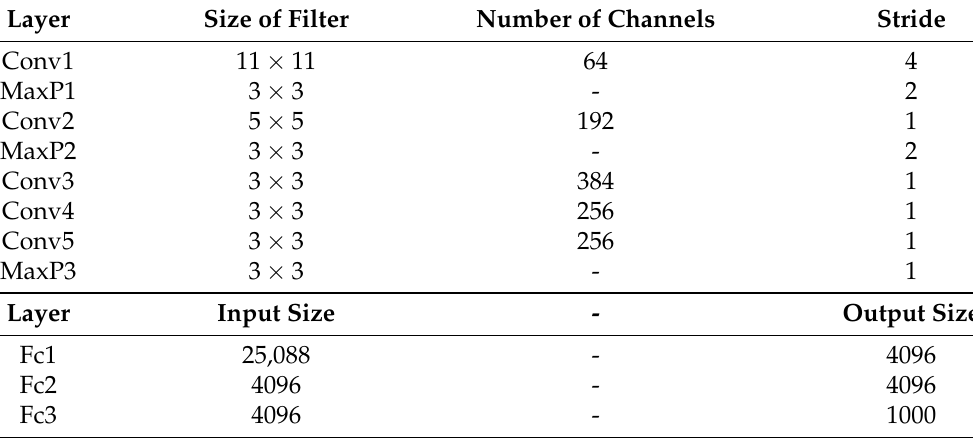
Table 1. The network structure and parameters of Alexnet model. Layer Size of Filter Number of Channels